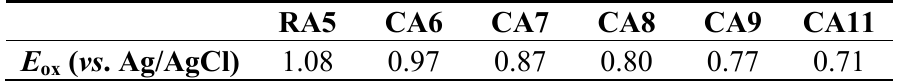
Table 2. One-electron oxidation potentials in dichloromethane (in V) (reprinted from [7] with permission of MDPI Publishing).